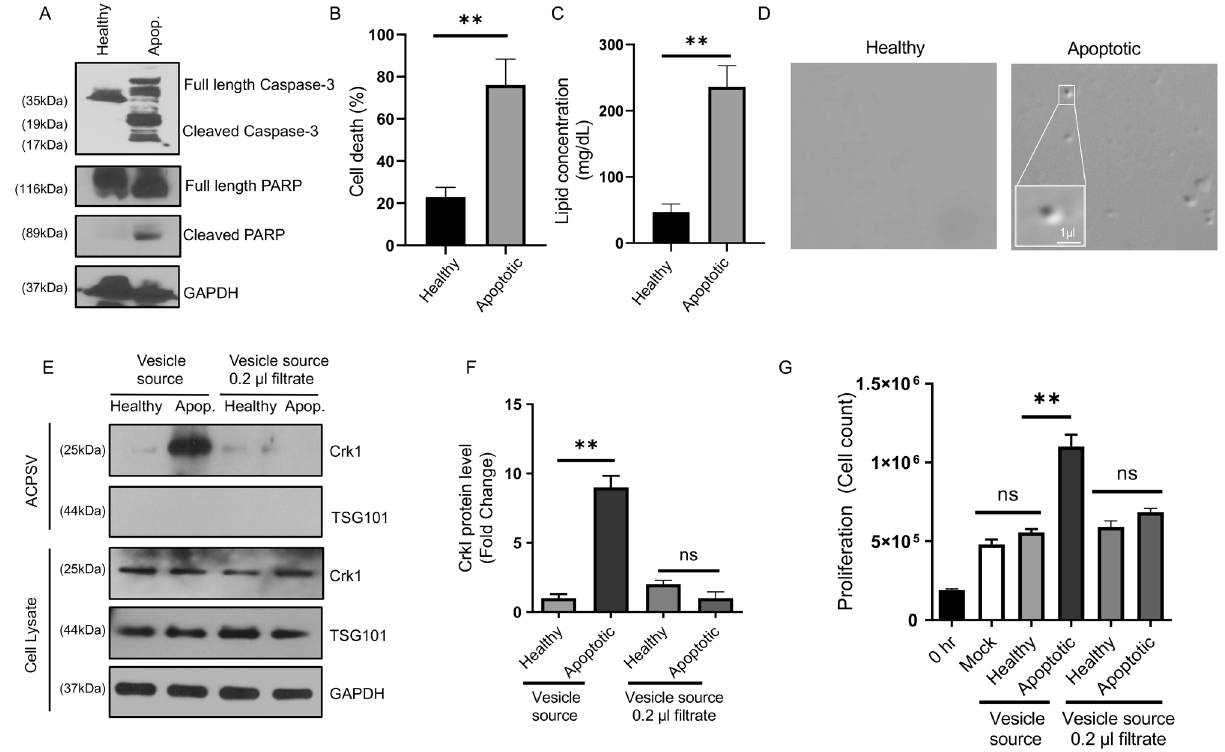
Figure 1. ACPSV production assessment in a primary human SCC cancer cell line. (A–G) The human squamous cell carcinoma primary cancer cell line (SSC-25) was either grown in serum-containing media (Healthy) or serum-deficient media (Apoptotic). (A) Apoptosis was assessed 48 h after serum starvation by Western blotting for apoptosis markers (activated Caspase-3 and PARP). (B) Percent cell death was assessed 48 h after serum starvation. (C,D) ACPSVs were purified from culture supernatant of healthy and apoptotic cells and assessed for their ACPSVs contents by lipid concentration assessment (C) and visualized by DIC imaging (D) . (E,F) The 16K fractions from healthy and apoptotic cell cultures were assessed for their ACPSVs by Western blotting, using ACPSV marker (CrkI) before and after passaging through 0.2-micron filters to remove ACPSVs. The 16K fractions were also probed for their exosome contents, using exosome marker TSG101 to show that these fractions are devoid of exosomes. Representative blot images are shown in (E) and the tabulated data, shown as the mean ± SEM are shown in (F) . (G) The 16K fractions of healthy and apoptotic cell cultures (before and after passaging through 0.2-micron filter) were assessed for their ability to stimulate proliferation in adherent HeLa cells. (N = 3; ns, not significant, *p < 0.01, **p < 0.001. Statistical analyses between groups were performed by One-way ANOVA, and pair-wise comparisons within groups were performed or by unpaired Student’s t